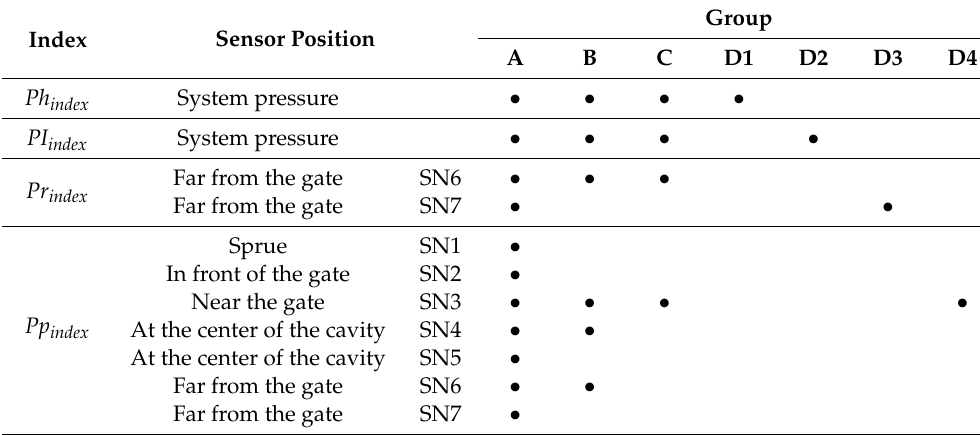
Table 7. List of sensors used in each